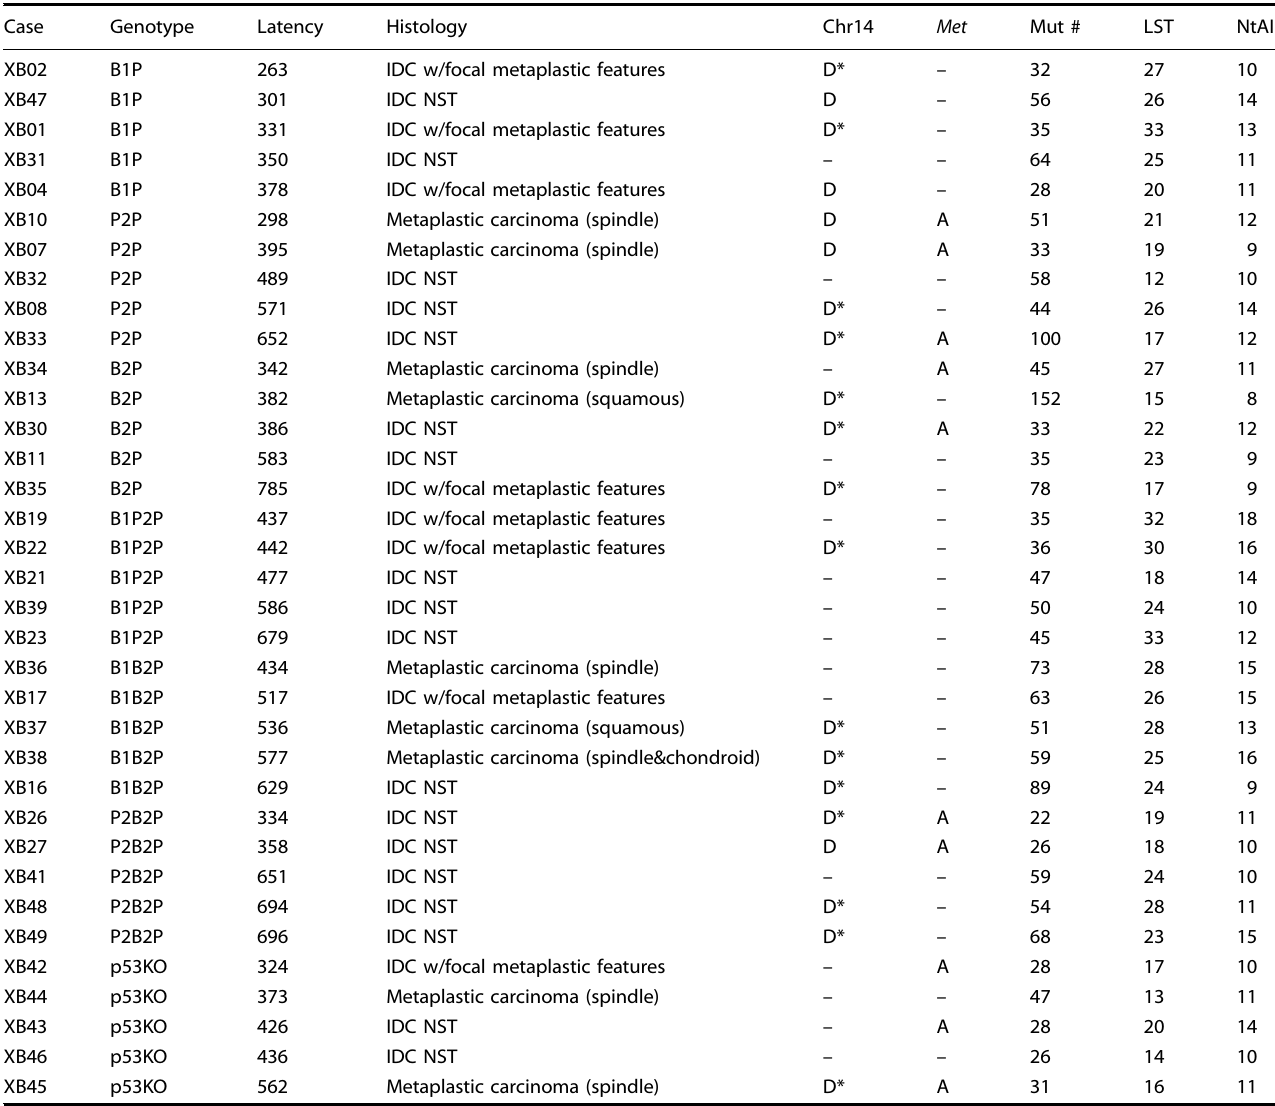
Table 1. Summary of mammary tumors analyzed in this